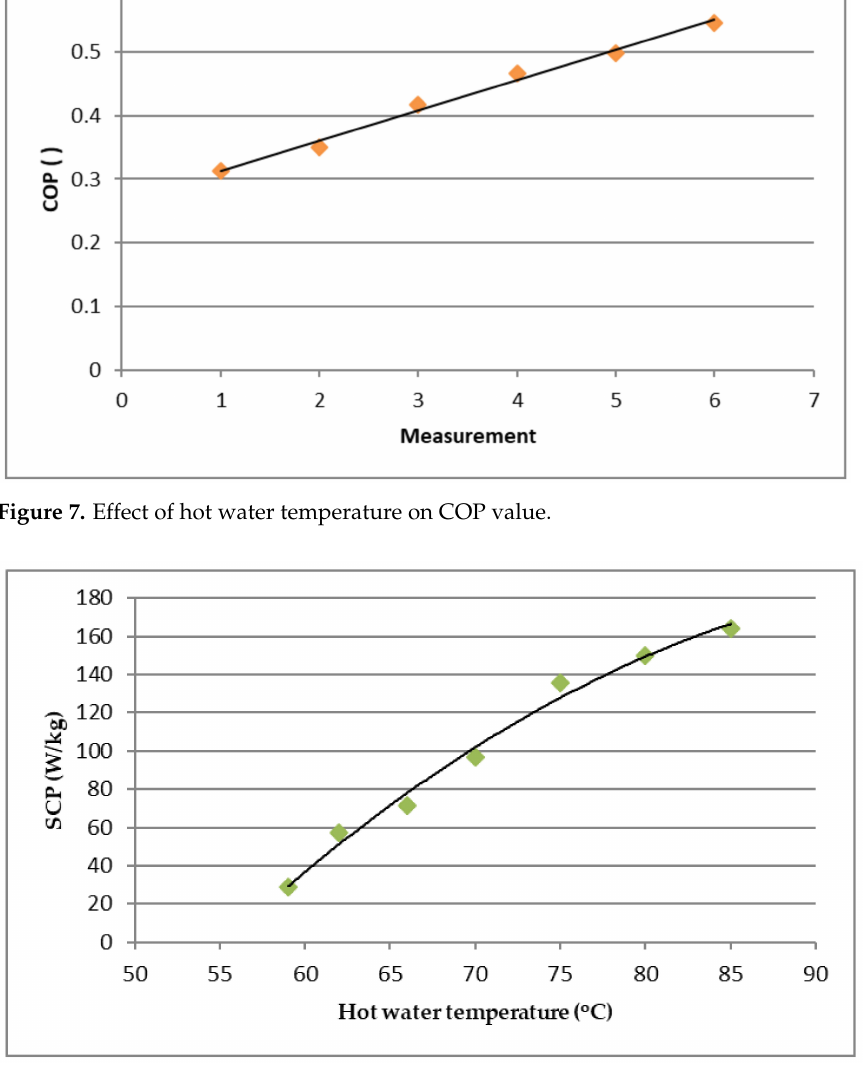
Figure 8. Effect of hot water temperature on SCP